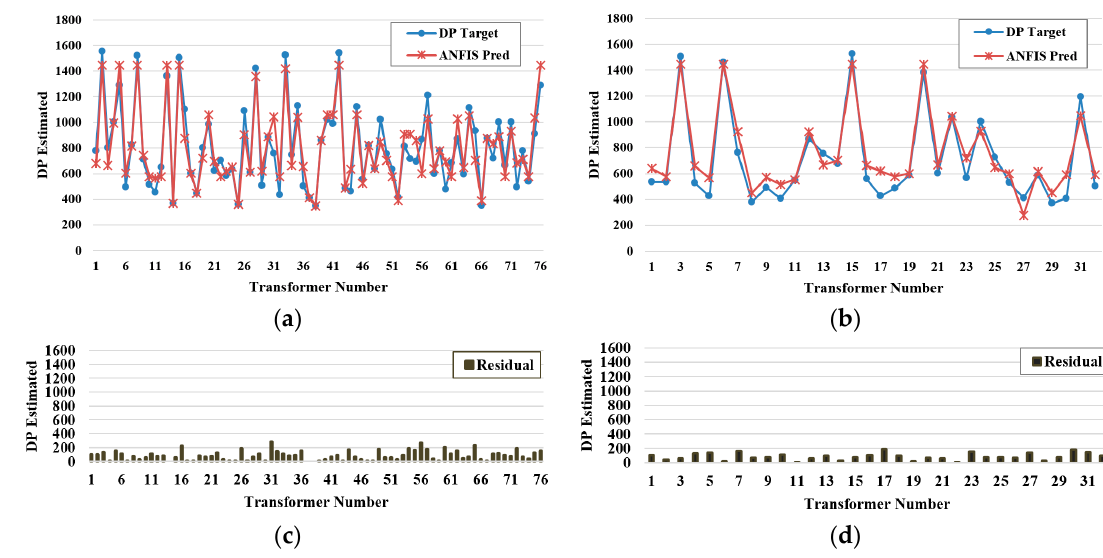
Figure 6. Proposed ANFIS model.